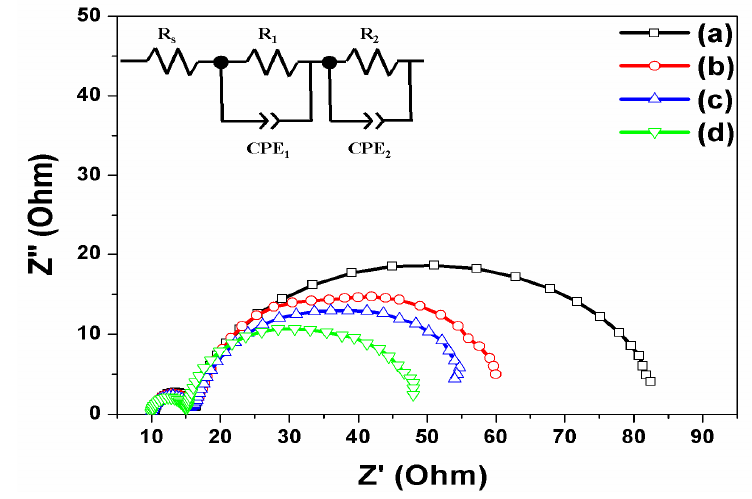
Figure 6. Impedance of DSSCs based on open-ended freestanding TiO 2 nanotube arrays: ( a ) Without carbon materials and large TiO 2 NPs; ( b ) With carbon materials; ( c ) With large TiO 2 NPs; and ( d ) With carbon materials and large TiO 2 NPs. Table 3. Parameters of impedance spectra of DSSCs based on open-ended freestanding TiO 2 nanotube arrays with/without carbon materials and with/without large TiO 2 NPs.